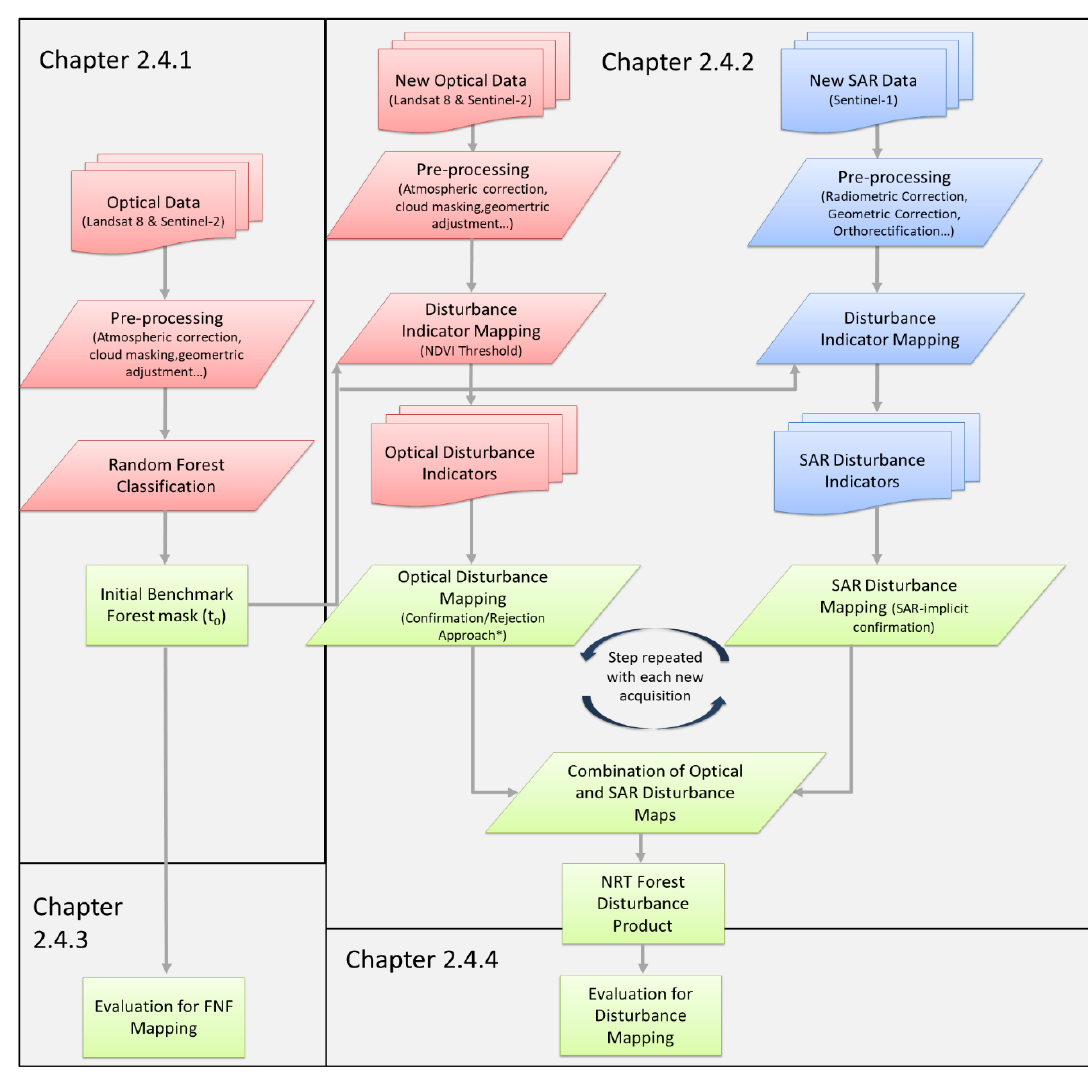
Figure 3. Overall Figure 3. Overall workflow.